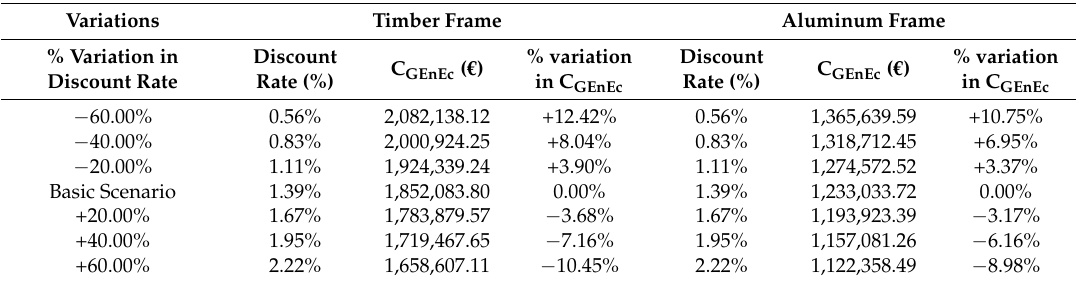
Table 16. Sensitivity analysis with decreased/increased discount rate.